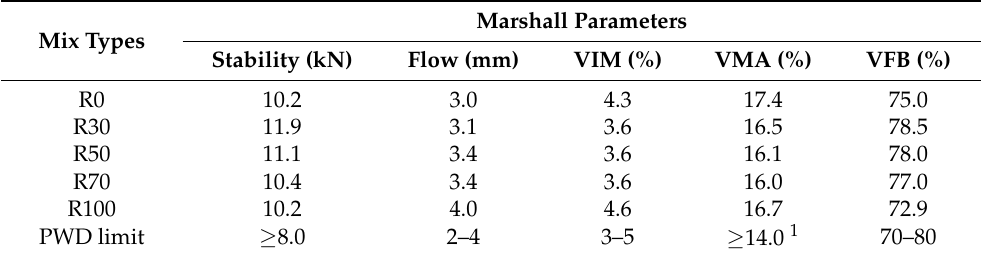
Table 5. Marshall test results in